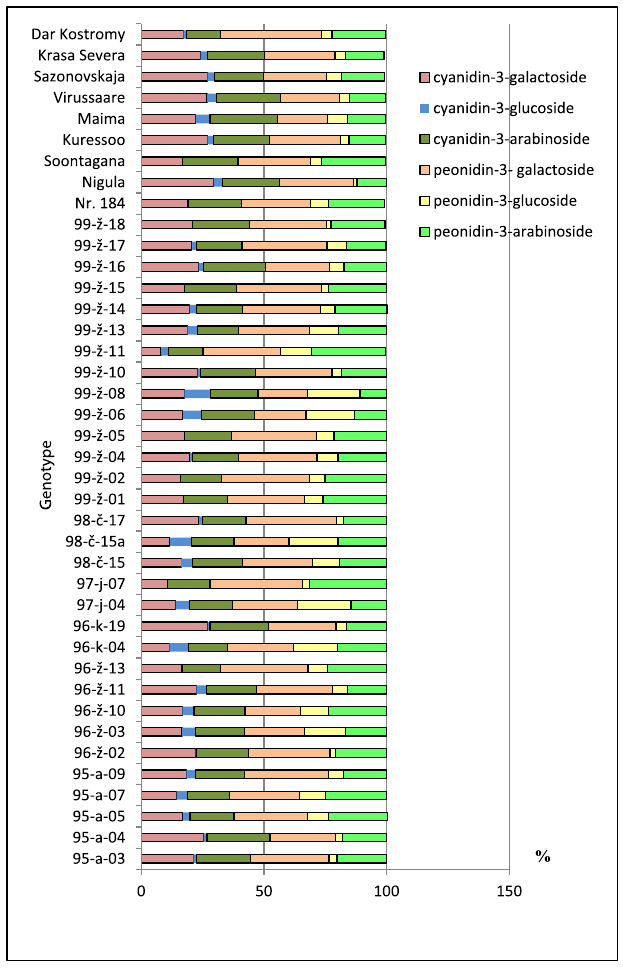
Fig. 1: Quantitative composition of anthocyanins in V. oxycoccos geno- types,